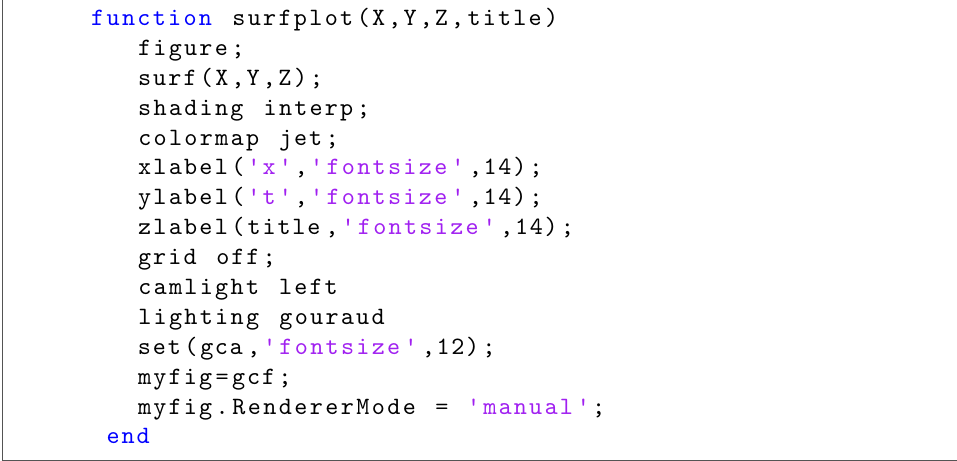
Figure 1. Function used to obtain the three-dimensional figures in our numerical experiments. The function uses Matlab commands, and the results were obtained using this computer